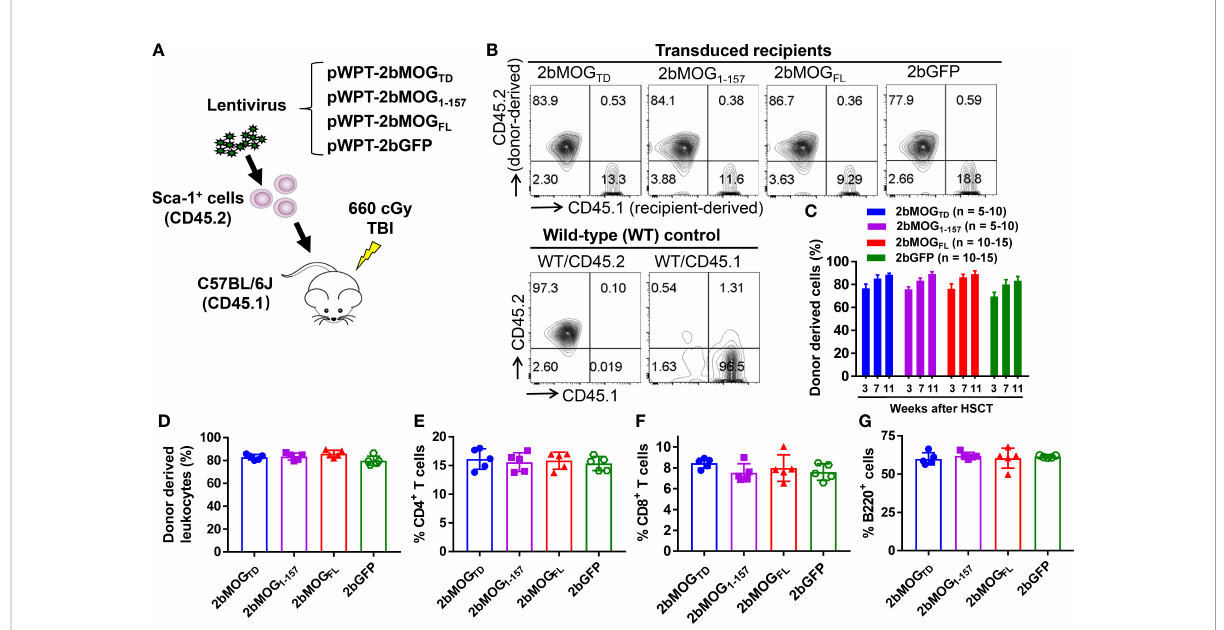
FIGURE 2 Targeting MOG expression to platelets did not affect the leukocyte pro fi le. Sca-1 + HSCs/progenitors isolated from CD45.2 WT C57BL/6J donors were transduced with lentiviruses and transplanted into CD45.1 recipients preconditioned with 660 cGy total body irradiation. After HSCT and BM reconstitution, blood samples were collected from recipients at various time points, and leukocytes were stained for CD45.1, CD45.2, CD4, CD8, and B220. After staining, cells were analyzed by fl ow cytometry. Representative results from week 7 from one trial after HSCT are shown. (A) Schematic diagram of experimental design to generate 2bMOG TD , 2bMOG 1-157 , 2bMOG FL , and 2bGFP recipients. (B) Representative dot plots from fl ow cytometry analysis of chimerism. (C) Chimerism in transduced recipients at various time points. (D) The chimerism in transduced recipients. (E) The percentage of CD4 T cells in transduced recipients. (F) The percentage of CD8 T cells in transduced recipients. (G) The percentage of B220 cells in transduced recipients. There were no signi fi cant differences in chimerism, CD4, CD8, or B cells between 2bMOG- transduced groups and the 2bGFP control group. (D-G) Each data point represents one mouse. Three replicate experiments were